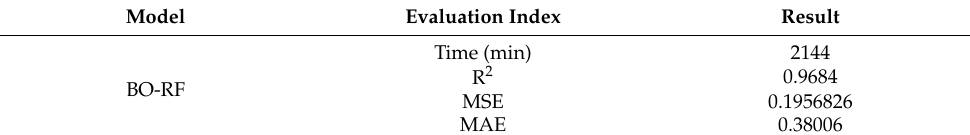
Table 13. Model accuracy evaluation results.